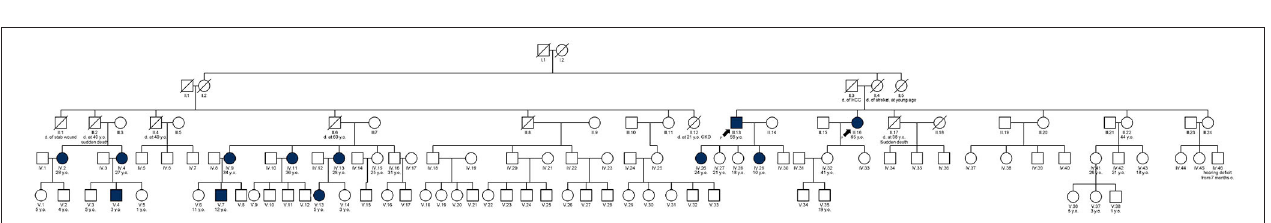
a basic arginine with a neutral, polar glycine (p.Arg49Gly) in the index case, who was referred for cardiomyopathy.